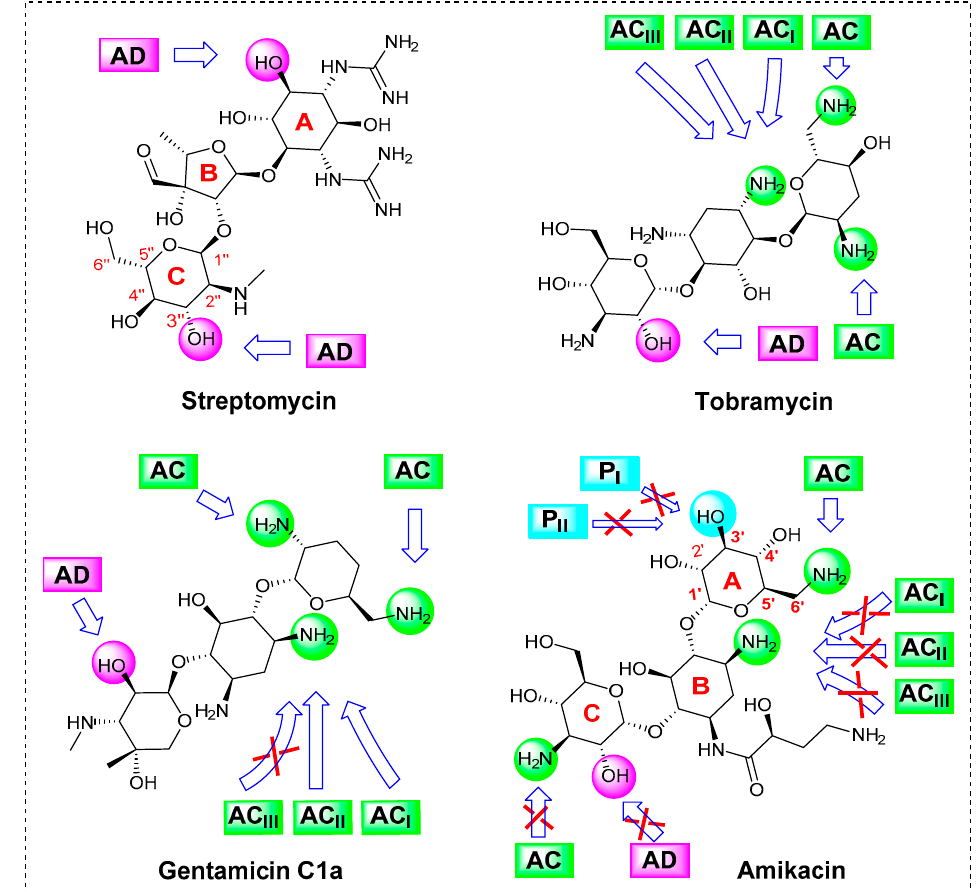
Figure 5. Chemical structures of aminoglycosides under investigation showing positions targeted by modifying enzymes: acetyltransferase (AC), adenylyltransferase (AD) and phosphotransferase (P). Gentamicin and amikacin show resistance to some AMEs. Adapted from [42] with some modifications.